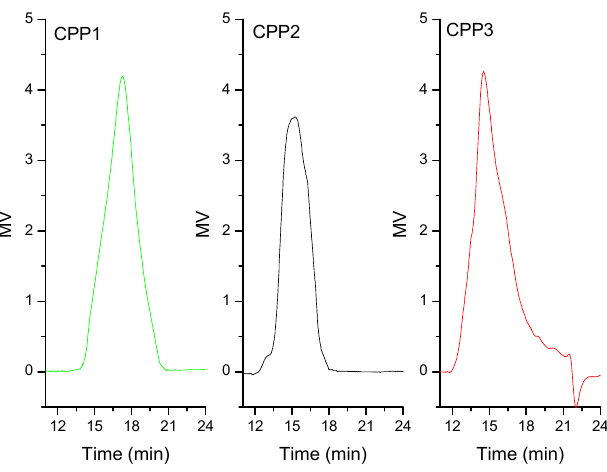
Figure 2. HPGPC chromatograms of CPP1, CPP2, and CPP3.